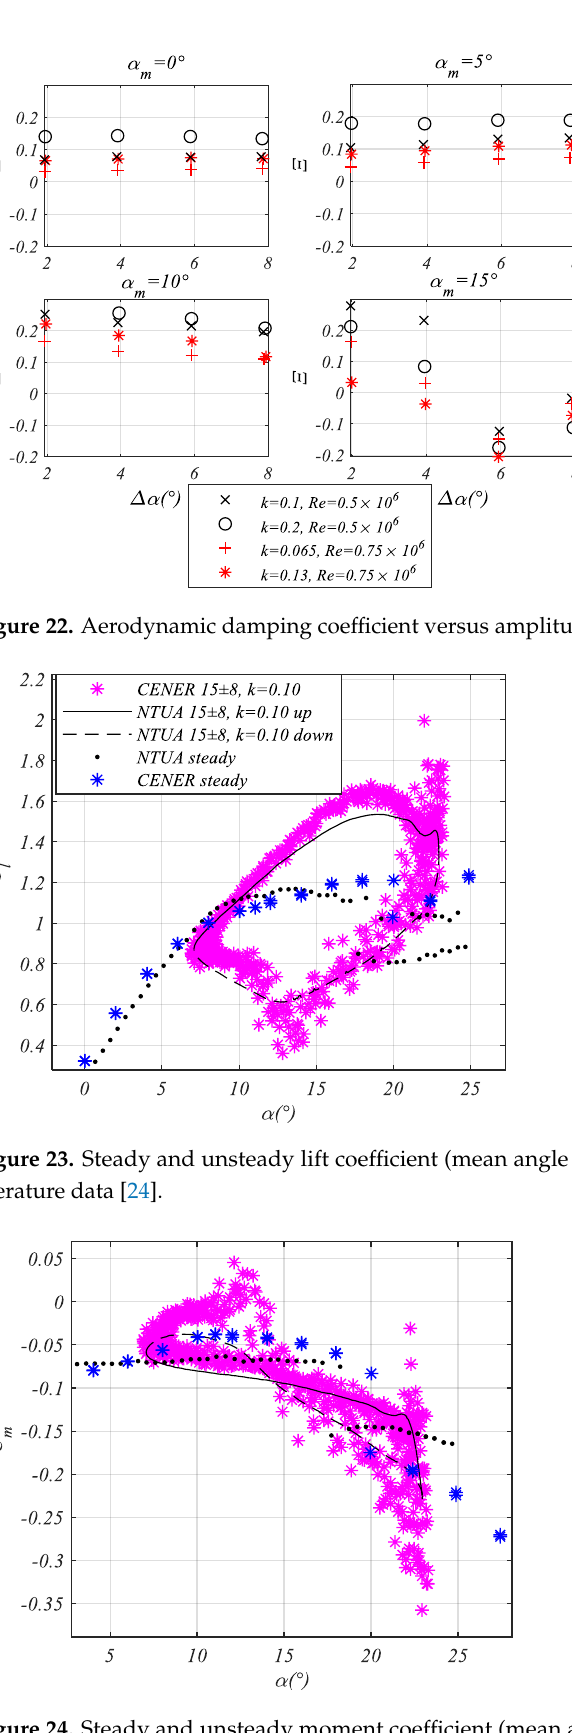
16 of 19 Figure 21. Aerodynamic damping coefficient versus mean angle of attack. Regarding the angle amplitude, there is no indication that the aerodynamic damping coefficient depends on this when the flow is attached (e.g. , 𝛼 𝑚 = 0° or 𝛼 𝑚 = 5°) as shown